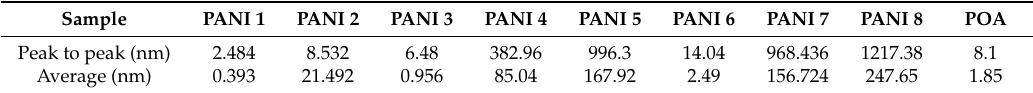
Table 2. Roughness measurements of PANI and POA layers.